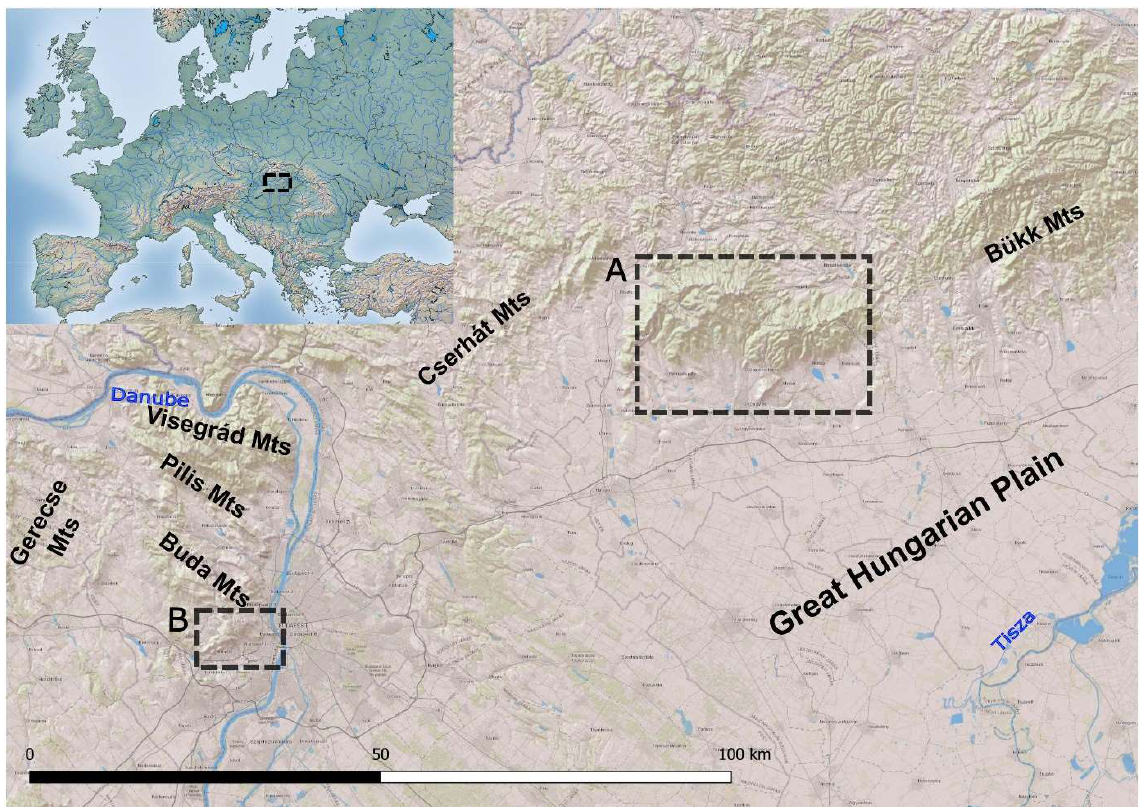
Figure 2. Location of the study areas in Northern Hungary. A: Mátra Mountains; B: southern part of the Buda Hills. (CAD by N. Faragó) Figure 2. Localisation des aires étudiés en Hongrie du nord. A: montagne de Mátra; B: partie méridionale des monts de Buda. (DAO: N.